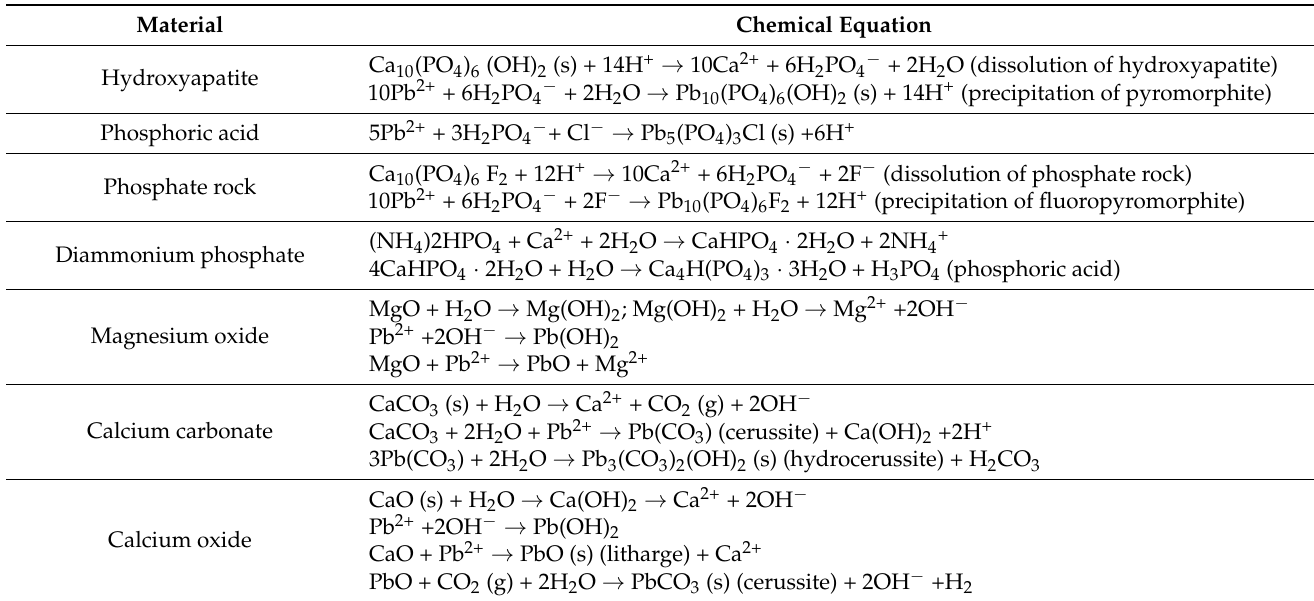
Table 2. Chemical reactions involved in the immobilization mechanisms of Pb 2+ [13,37,38,50,51].